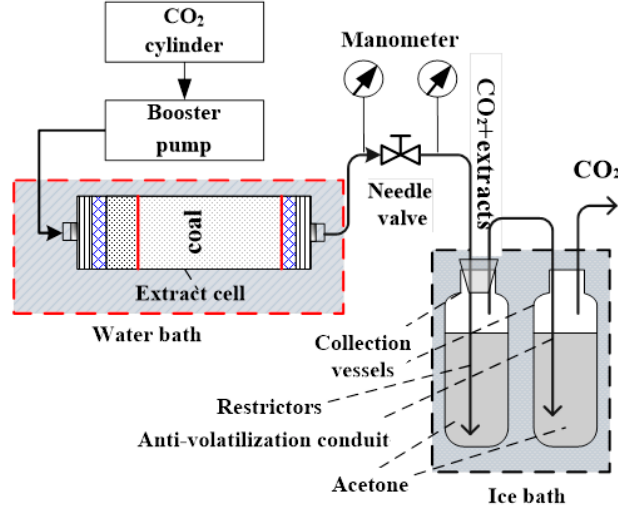
Figure 1. A simplified layout of the experimental apparatus.